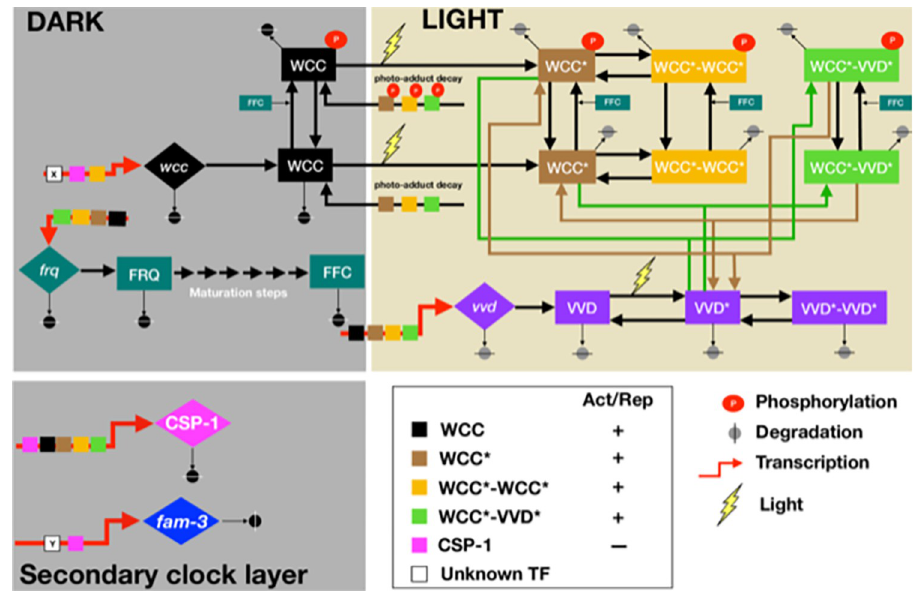
Fig 1. Schematic of the Neurospora circadian clock in dark and